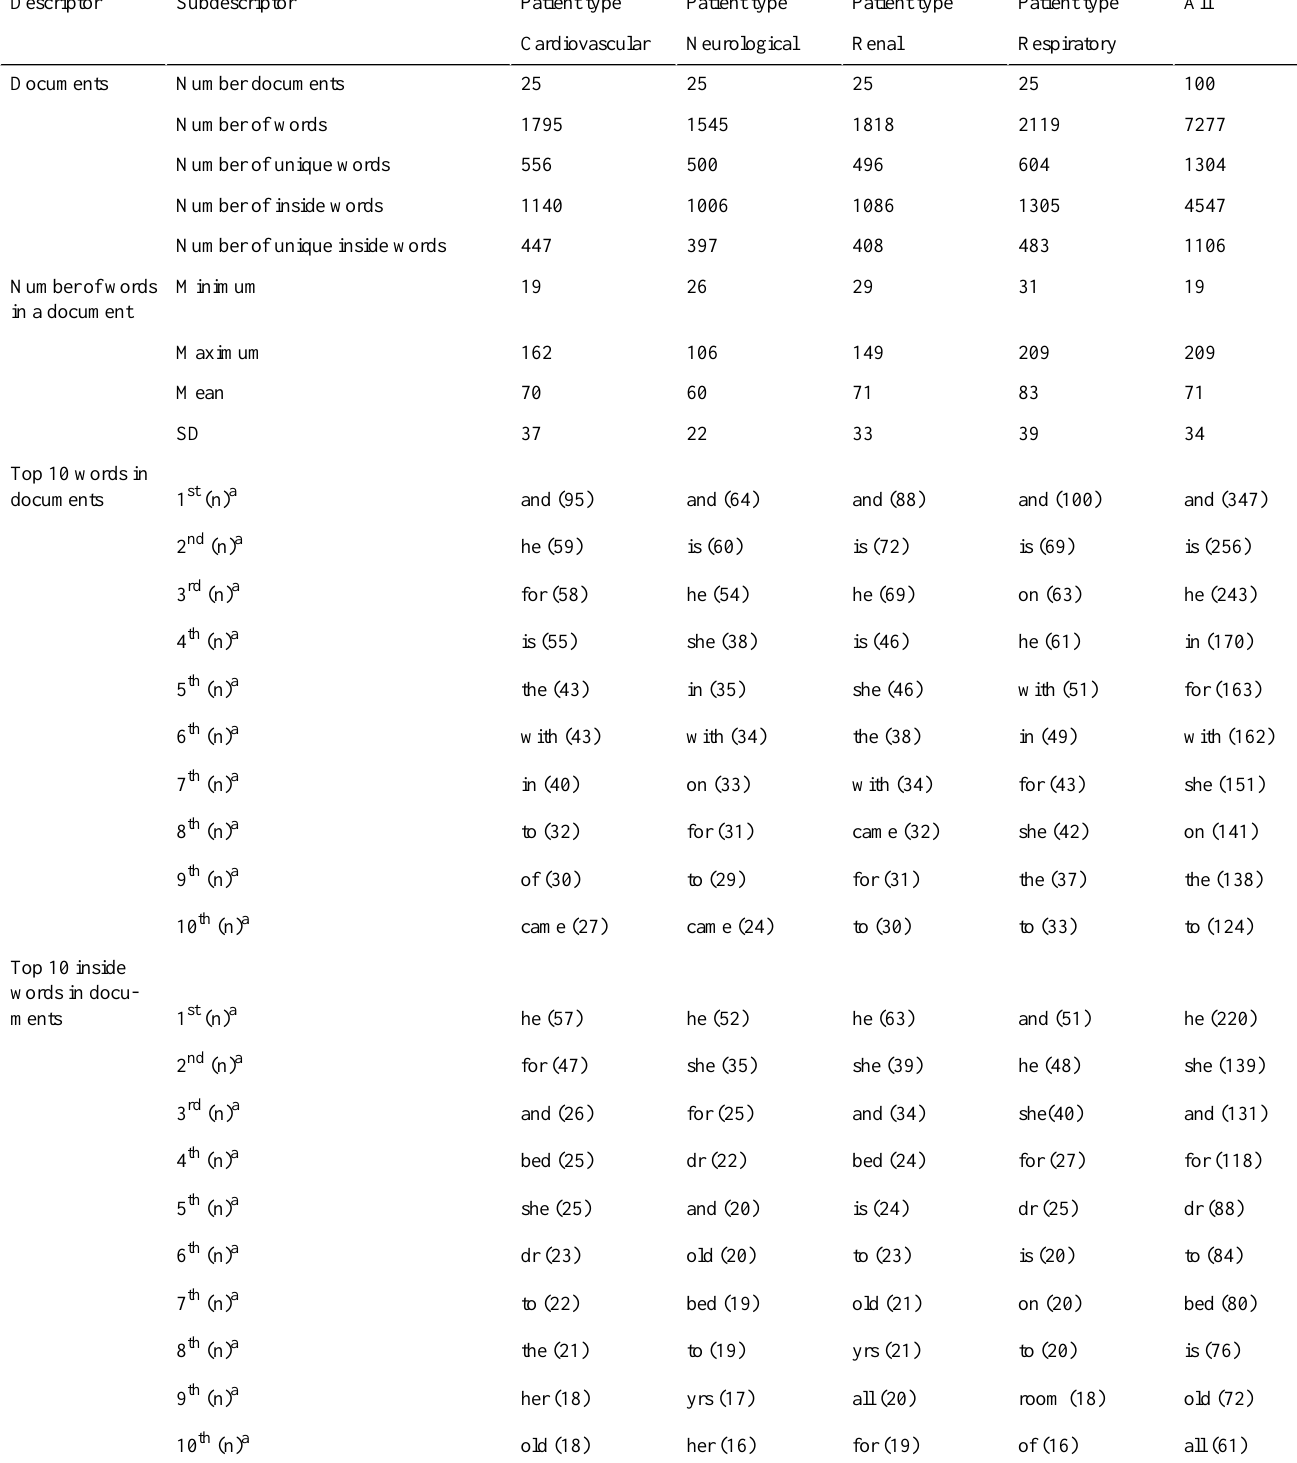
AllPatient typePatient typePatient typePatient